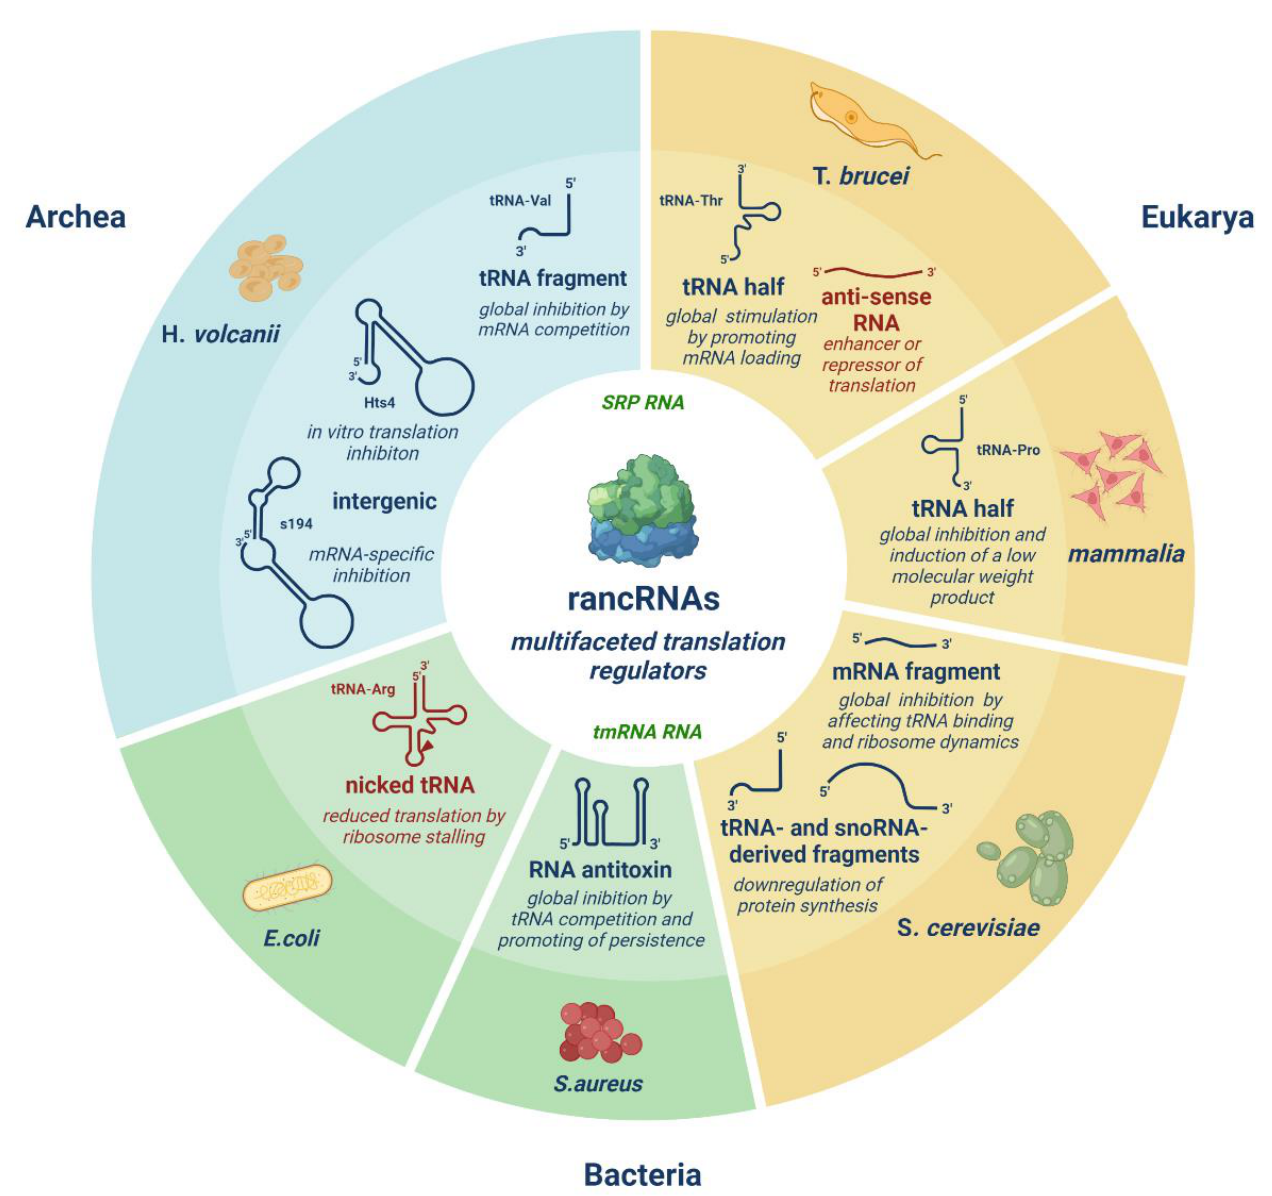
Figure 1. Overview of the expanding class of ribosome-associated ncRNAs (rancRNAs) representing a vast heterogeneous group of riboregulators. RancRNAs differ in their origin, length, and mode of action. RancRNA-mediated translation regulation has been identified in various organisms, spanning all three domains of life. Blue: validated rancRNAs. Red: novel potential rancRNAs. Green: well-characterized rancRNAs (tmRNA in bacteria, SRP RNA almost universally conserved).